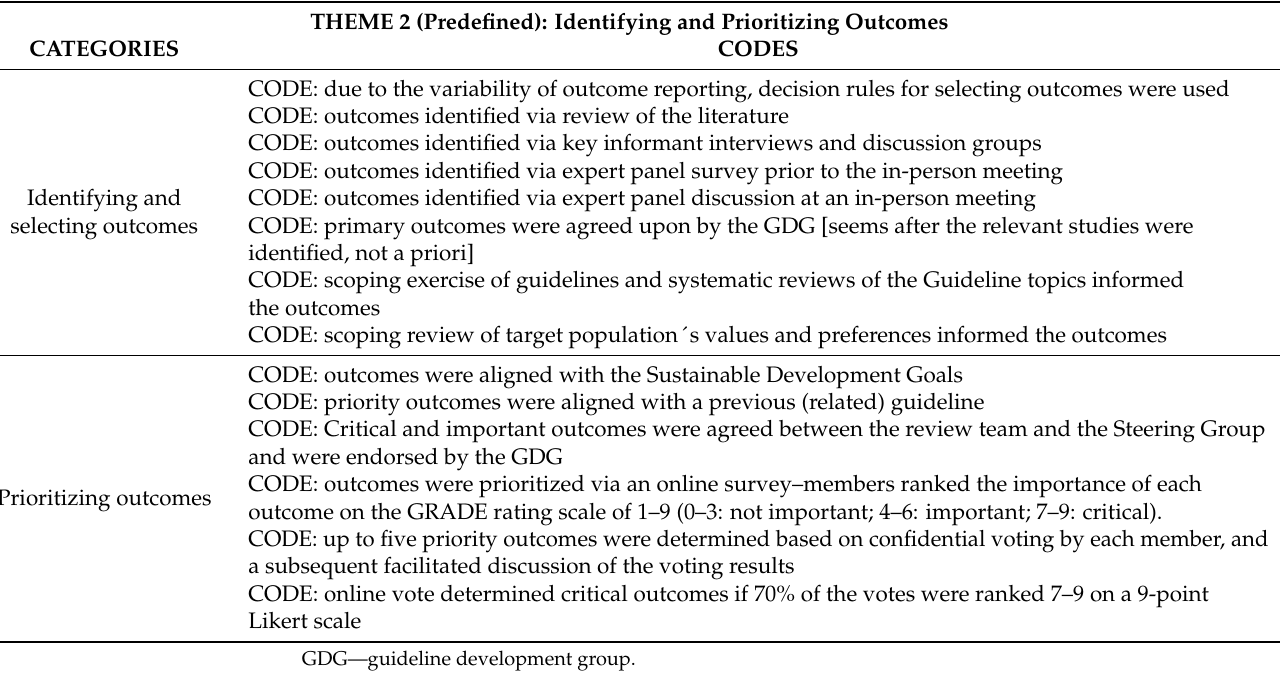
Table 3. Categories and codes for theme 2.